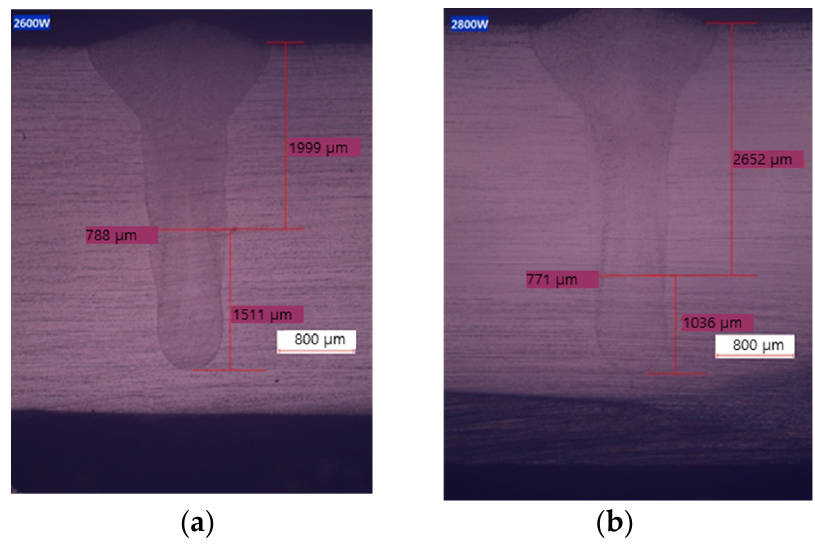
Figure 8. Cross-sectional macrograph of stiffener welding joints: ( a ) skin thickness: 2.0 mm + stiff. thickness: 2.0 mm; ( b ) skin thickness: 2.67 mm + stiff. thickness: 2.0 mm.